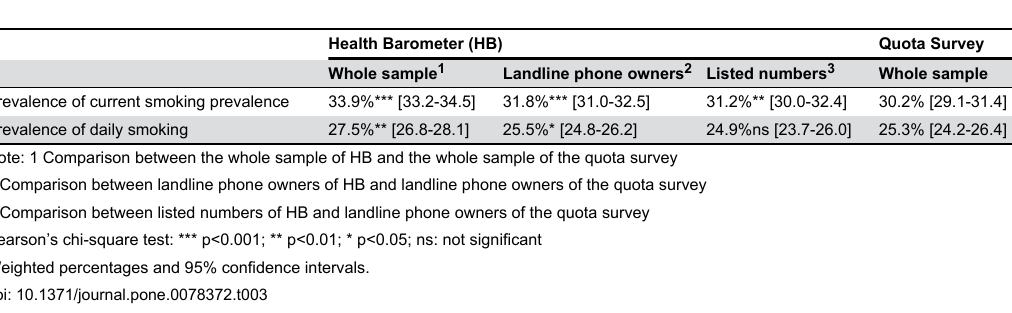
Table 3. Prevalence of current and daily smoking in both surveys according to telephone equipment in 15–75